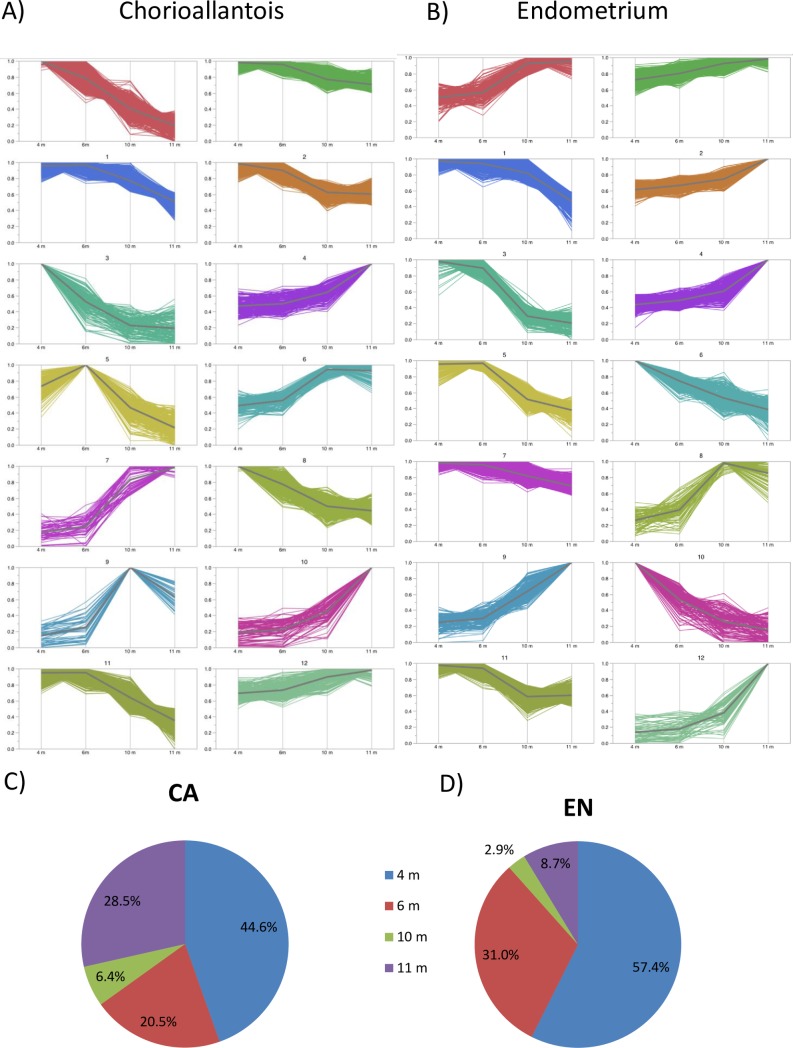
Differential gene expression across gestation.Gene clustering by K-means cluster based on normalized gene expression of genes with an FDR P Value < 0.05 across gestation. Genes were normalized on an individual basis, with the highest expression set to 1. The 14 clusters for A) chorioallantois and B) endometrium are visualized. Pie charts indicate the proportion of genes which are highest at each time point for C) chorioallantois (CA) and D) endometrium (EN). For a more in depth analysis of these data, including gene identities / cluster, please see S2 Table.